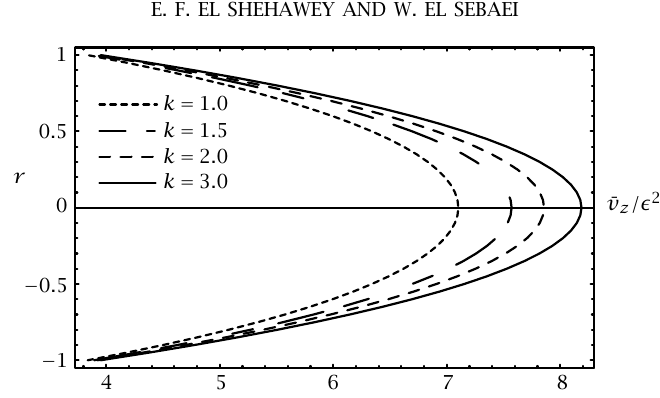
Figure 6.7 . The effect of the permeability parameter k on the mean-velocity distribution and reversal flow at Re = 10 . 0, (∂P/∂z) 2 = 2 . 0, and α = 0 . 1.